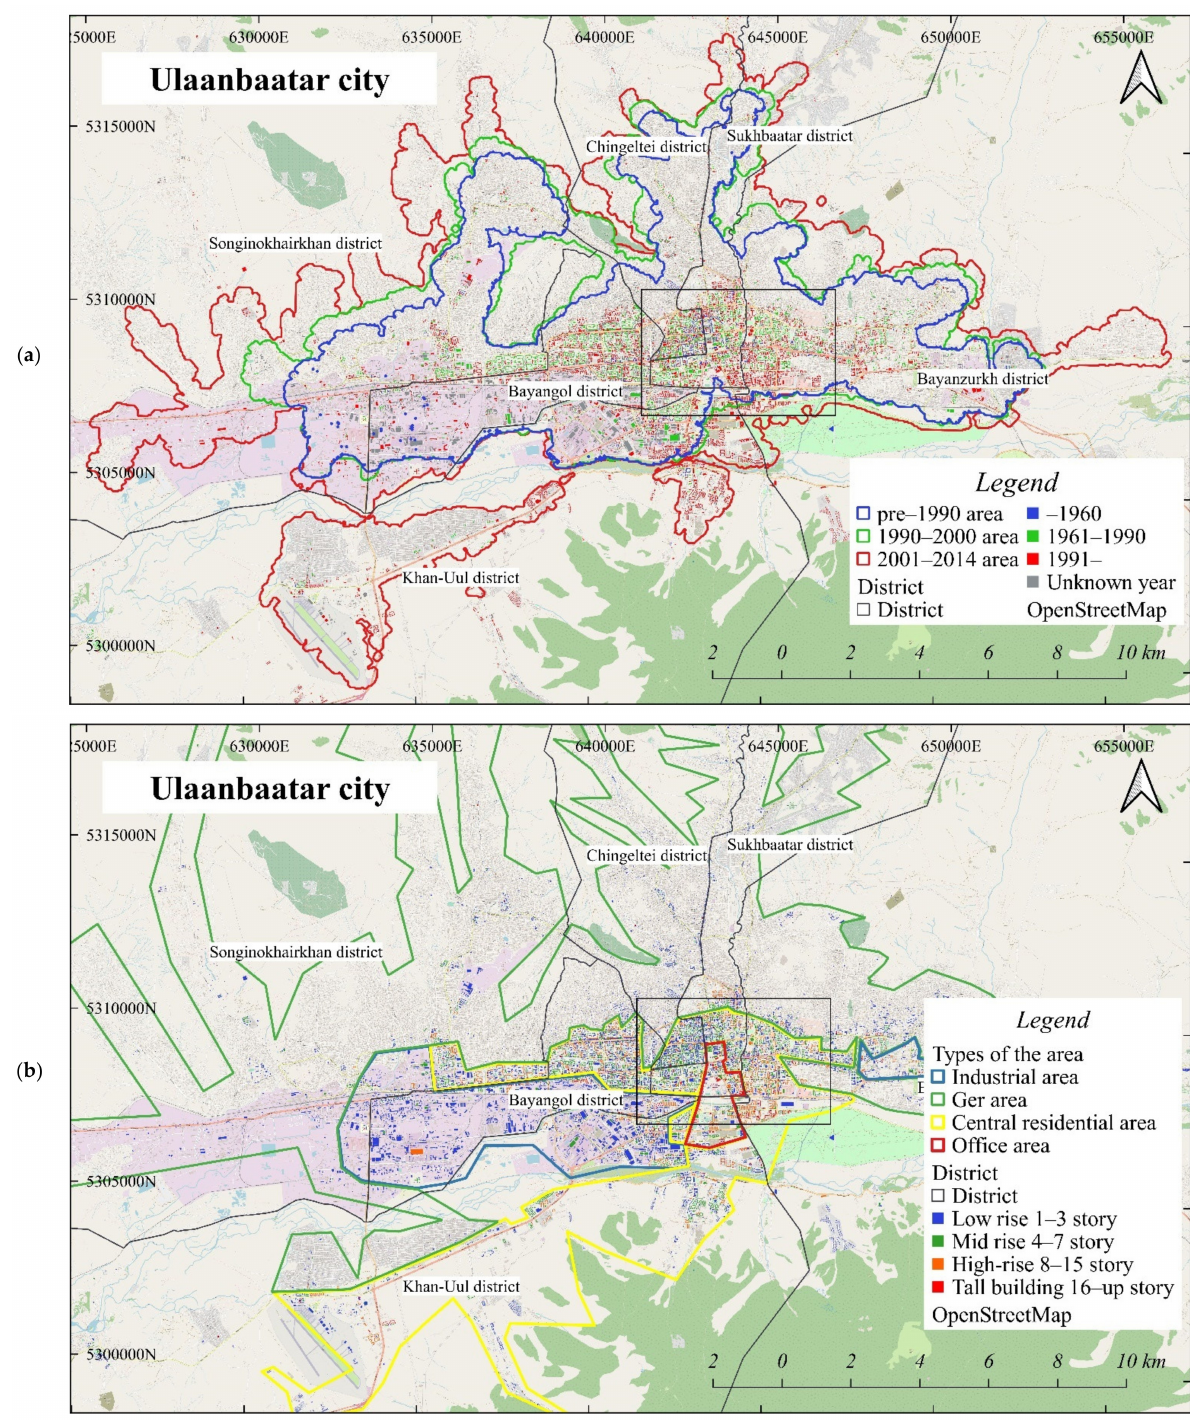
Figure 2. ( a ) Construction year distribution in Ulaanbaatar city with urban expansion [29]; ( b ) distri- bution of building heights with urban land use